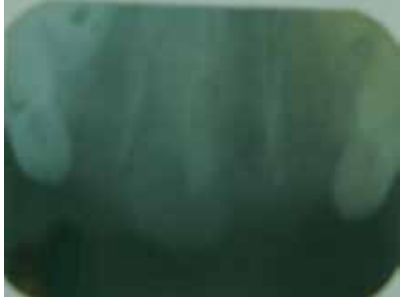
Fig 4. Procedure of re-implantation